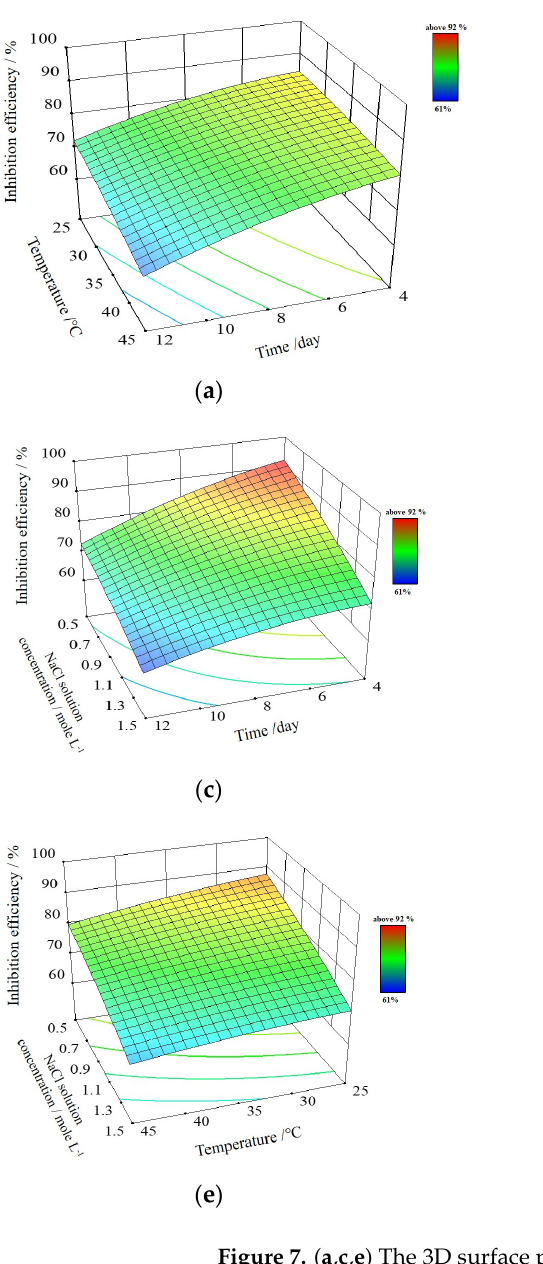
The optimal levels of the three components at the maximum point of the polynomial model were 4 days at 28.7 ◦ C and 0.53 M NaCl solution concentration to obtain